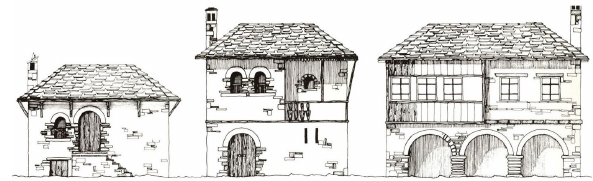
Figure 2. Typical house typology: “grandmother” (left), “mother” (middle), “daughter” (right) (Source: Stamatopoulou,